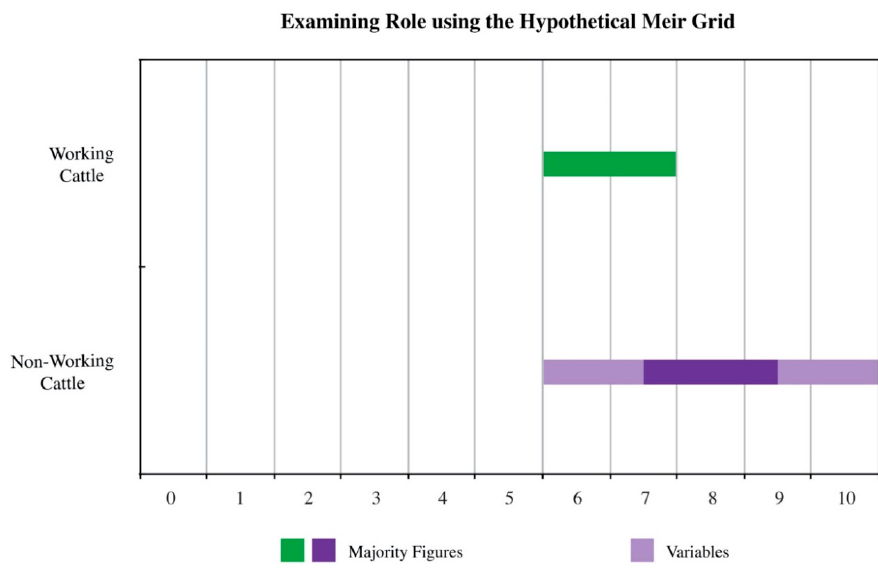
Figure 11. Examining the role of cattle using the hypothetical Meir grid.